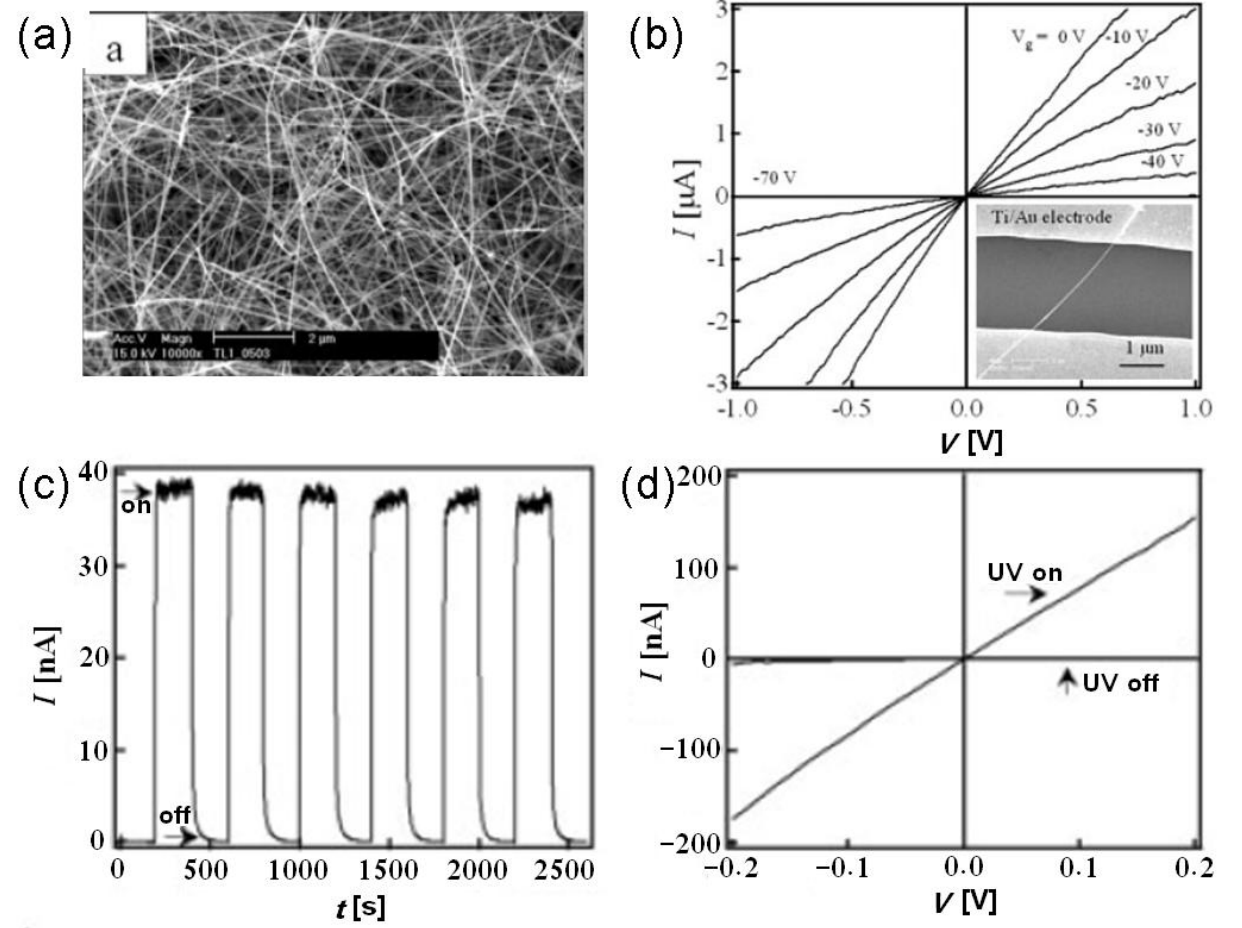
Figure 4. (a) Scanning electron microscope (SEM) image of SnO dependent I-V curves of a single SnO illumination turned on and off repeatedly; (d) I-V curves taken with and without UV illumination. Reproduced from